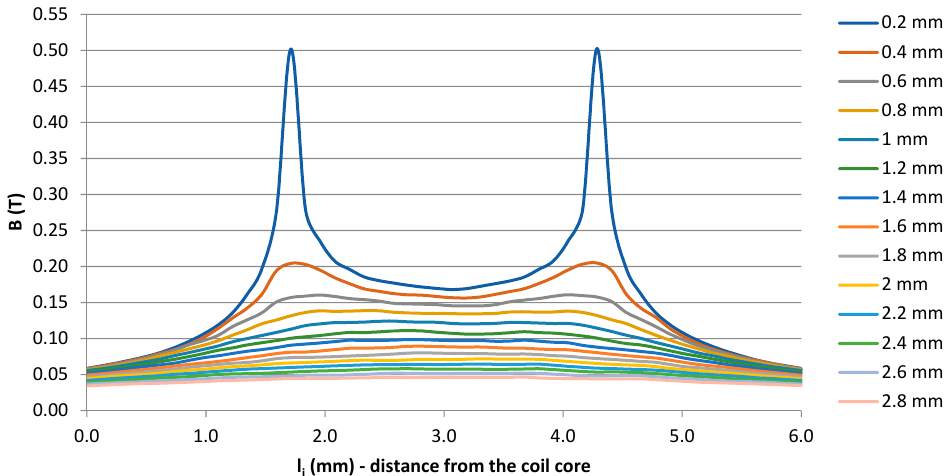
Figure 6. Magnetic induction distribution in dependency on the distance from the air gap and the length along the airgap for inductor described by situation Figure 4a.